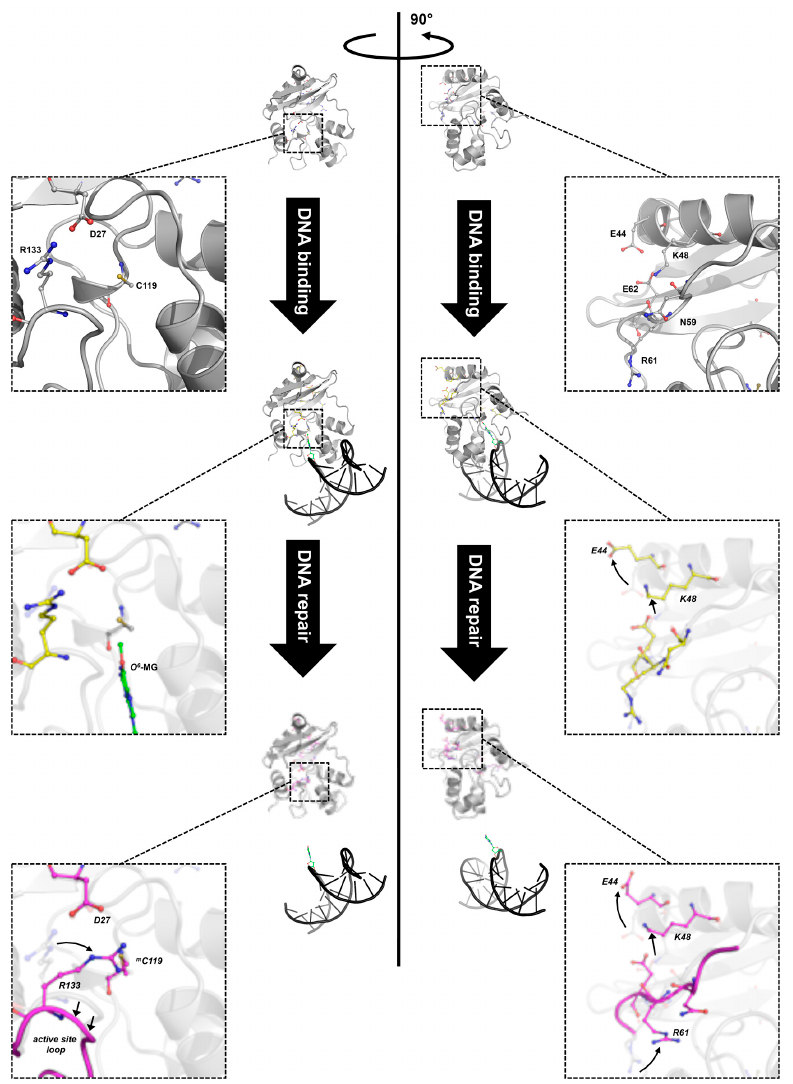
Figure 5. Different stages of DNA repair reaction of Ss OGT. The free form of Ss OGT (PDB ID: 4ZYE, in grey) recognizes and binds the alkylated DNA, leading to reversible conformational changes in its own structure (PDB ID: 4ZYD, in yellow), mainly involving the K48-network. Upon the alkyl transfer, the protein undergoes dramatic changes (PDB ID: 4ZYG, in magenta), which cause its inactivation and degradation. Insets: zoom-in of regions involved in the main conformational changes (adapted from [30,61]). Green, methylated guanine. Amino acid atoms are coloured according the CPK convention (carbon, in the corresponding colour of each 3D structure; oxygen, in red; nitrogen, in blue, sulphur, in yellow).